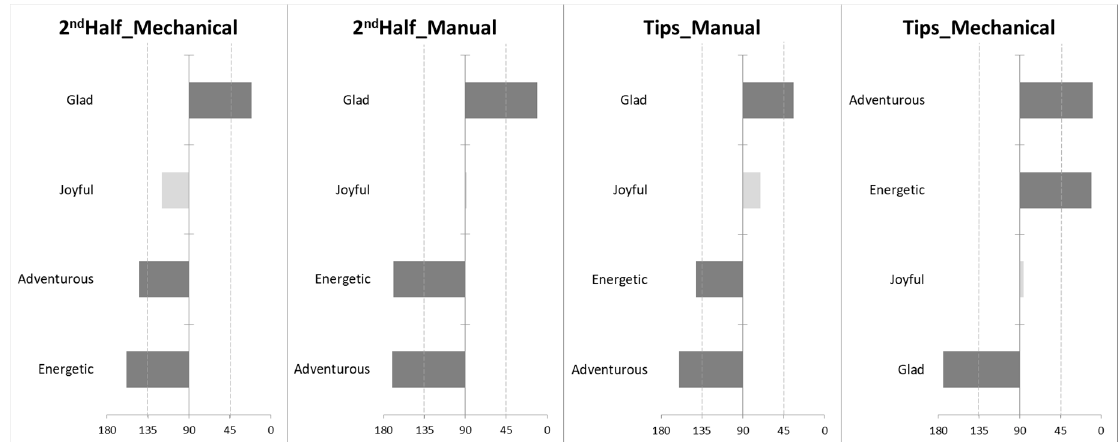
Figure 4. Angles (in degrees) between the vectors from the projections of the lemon verbena infusions (plant part and type of cut) and food-elicited emotion terms in the correspondence analysis map, resulting from multidimensional alignment (MDA) analysis. Dark bars represent the angles below 45°—with emotion terms positively correlated with the samples, as well as the angles above 135°—with emotion terms negatively correlated with the samples.